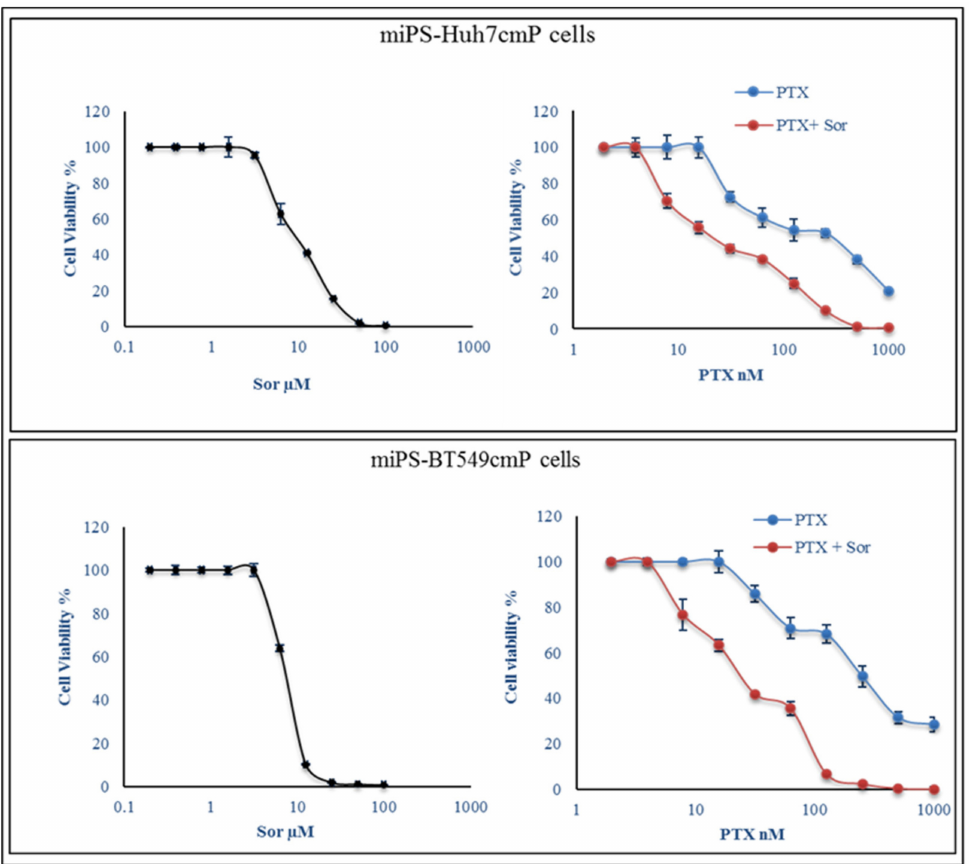
Figure 1. Combined treatment reduced cell viability than monotherapies. The e ff ect of paclitaxel (PTX) and sorafenib (Sor) on cell viability was measured by MTT assay as described in Materials and Methods. Combined treatment inhibited viability in both cell lines in a dose and time-dependent manner. Experiments were performed in triplicate and data are presented as the mean ± SD of three separate